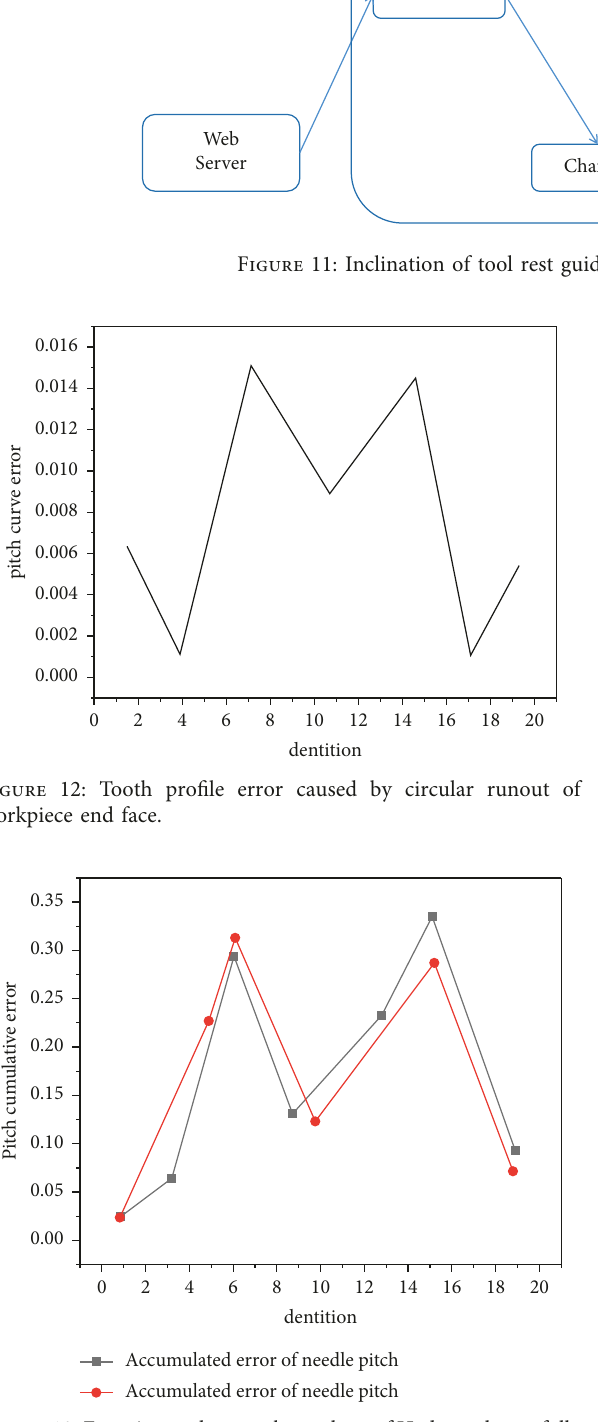
Figure 13: Experimental network topology of Hadoop cluster fully distributed mode in cloud platform.